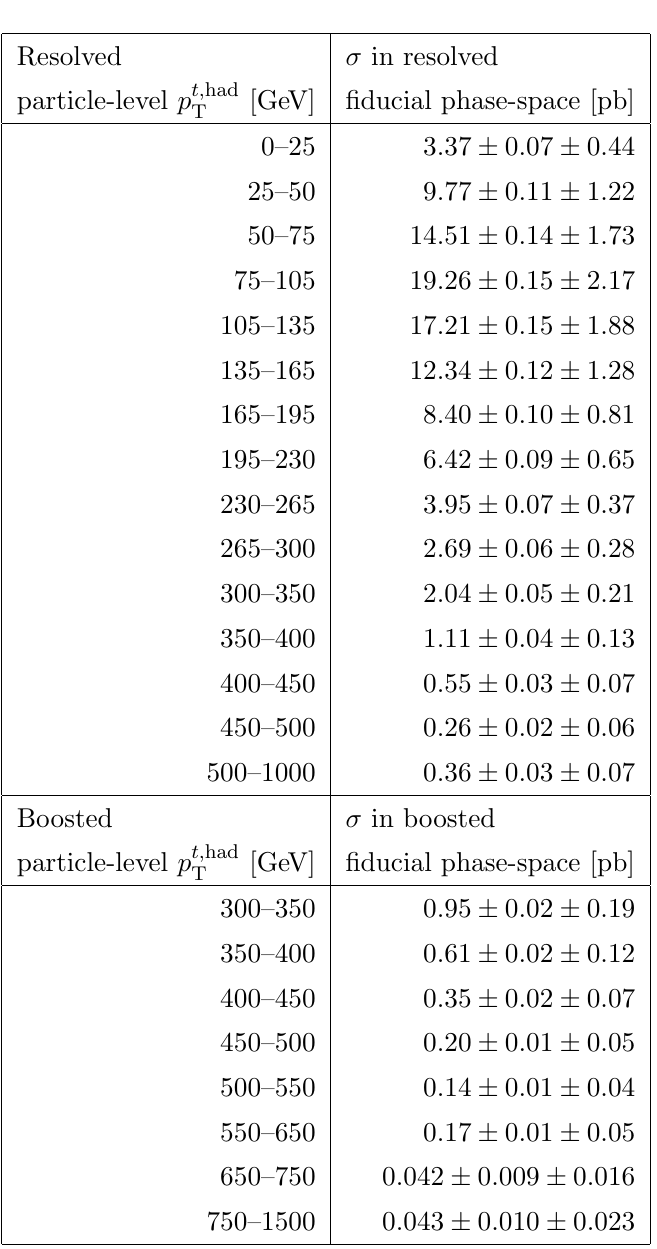
Table 6. Unfolded (cid:12)ducial phase-space di(cid:11)erential cross-section values in bins of hadronic top- quark transverse momentum for the resolved (top) and boosted (bottom) topologies. The (cid:12)rst uncertainty is statistical and the second one is systematic.